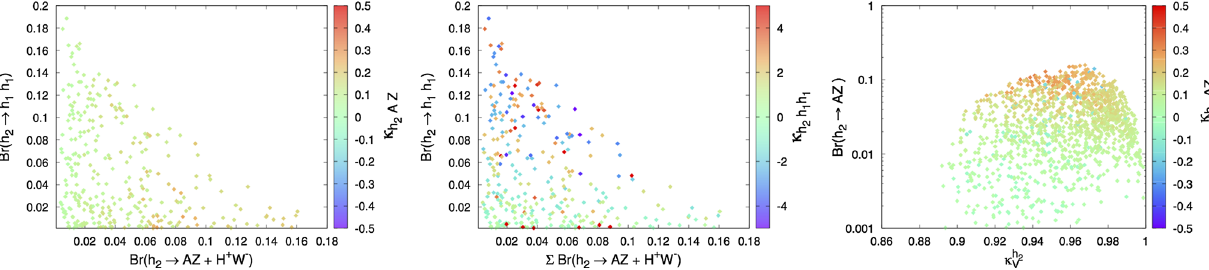
Fig. 7 Br ( h 2 → h 1 h 1 ) and Br ( h 2 → AZ + H + W − ) versus κ h a function of κ h at 95% C . L in N2HDM 2 AZ